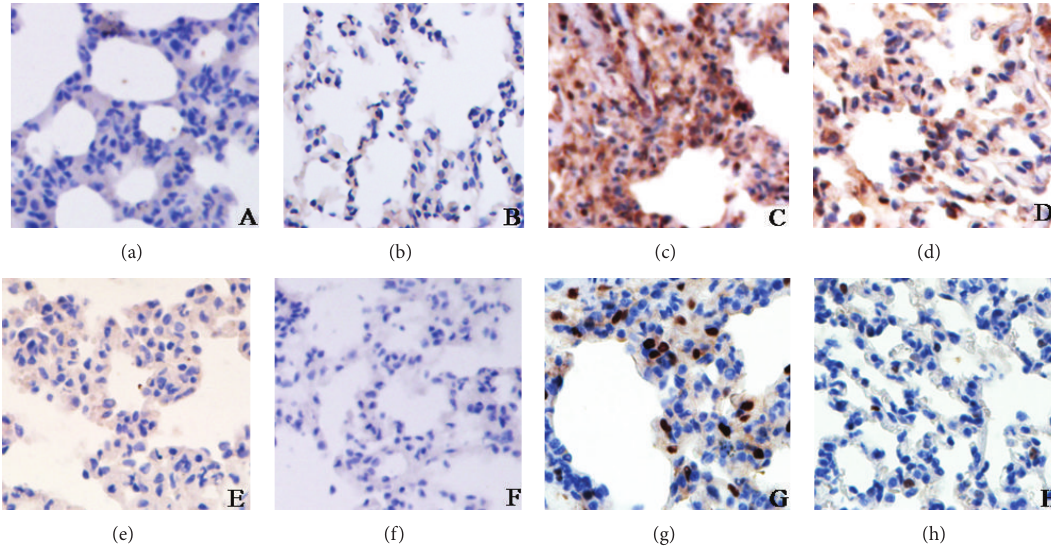
Figure 5: Effect of EGCG pretreatment on the expression of STAT1 and p-STAT1 in lungs in seawater aspiration-induced ALI: (a)–(d) the expression of STAT1; (e)–(h) the expression of p-STAT1; (a) and (e) the control group; (b) and (f) the EGCG group; (c) and (g) the seawater group; (d) and (h) the seawater + EGCG group (original magnification 200 ×